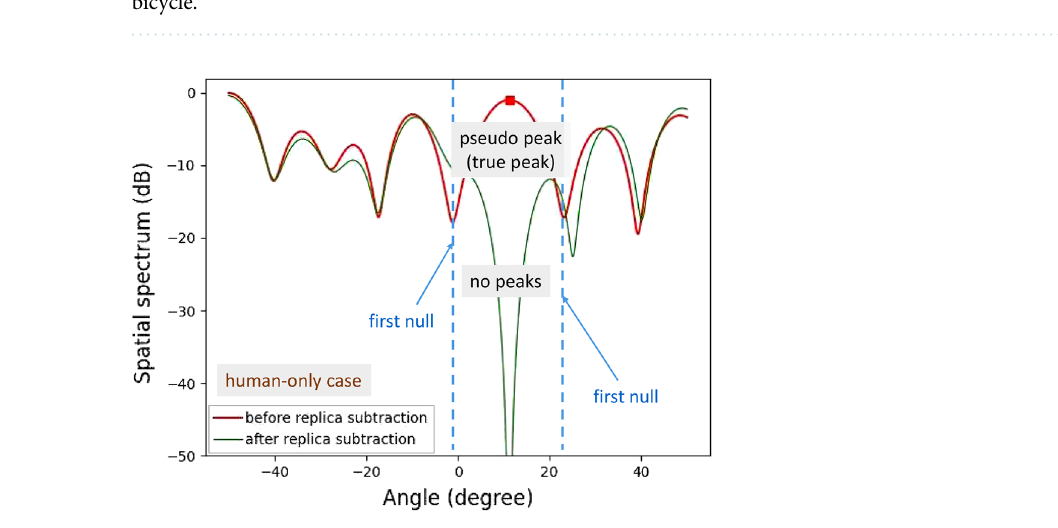
Figure 13. Demonstration results for horizontal angle estimations of on-road obstacles: human-only.